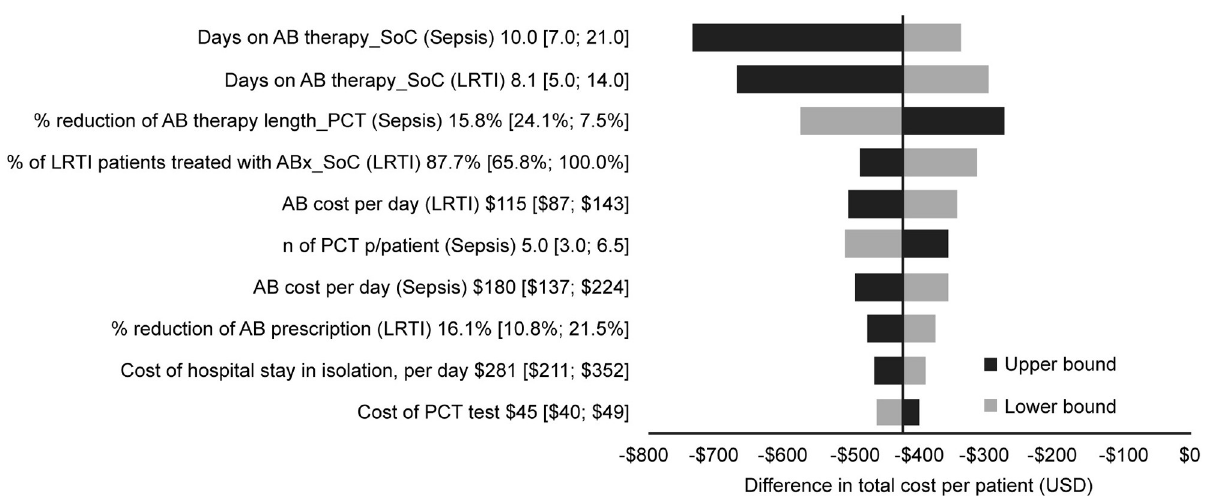
Fig 2. Tornado analysis. Impact of parameter variations on costs results per patient. Argentina, 2020. The figure shows how much the base case result (− $422 . 4 USD) would change if parameters were the maximum or minimum value instead of the base case . For example , the base case value for “Days on AB therapy_SoC (Sepsis)” was 10 . 0 . If this parameter is changed to its minimum value of 7 . 0 (instead of 10 . 0) the model predicts a result of −$337 USD (grey bar) . On the contrary , if it is changed to 21 (its maximum value) the model result would be −$736 USD . AB, antibiotic; ABx, antibiotics; LRTI, lower respiratory tract infection; PCT, procalcitonin; SoC, standard of care; USD, US dollars.